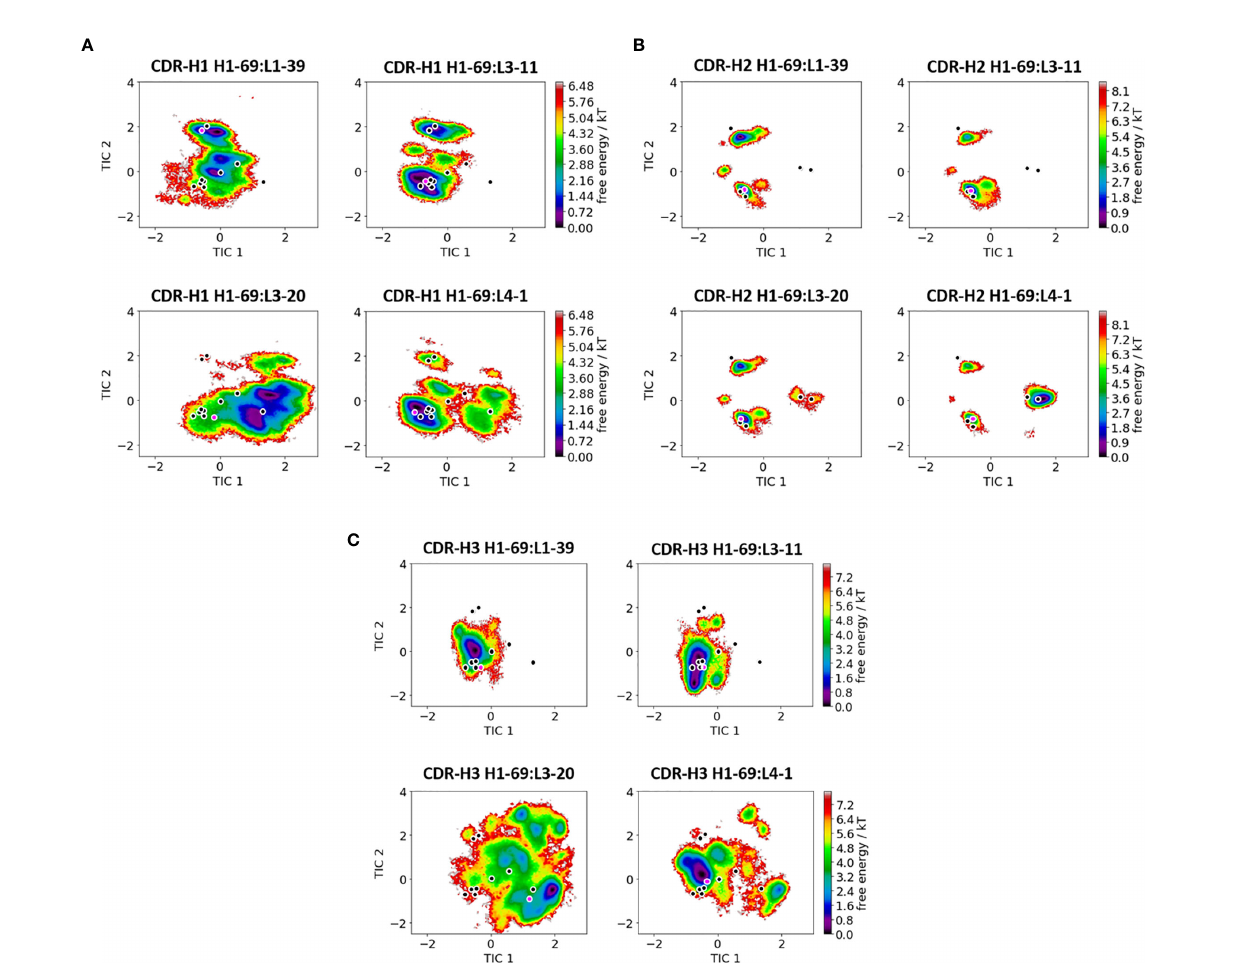
FIGURE 1 | Comparison of all V H -CDR loops consisting of the heavy chain germline H1-69. (A) Shows the free energy surfaces of the CDR-H1 loop paired with different light chain germlines in the same coordinate system. The available canonical cluster structure representatives from the PyIg database for the CDR-H1 loop of length 13 are projected into the free energy surface and are depicted in black. In pink the respective crystal structures, which were used as starting structures are illustrated (PDB accession codes: 5I15, 5I16, 5I17 and 5I18). (B) Displays the resulting free energy landscapes for the CDR-H2 loop projected into the same coordinate system. The canonical cluster structures of the CDR-H2 loop of length 10 are projected and illustrated in black. The pink dot represents the starting X-ray structures for the simulations. (C) Shows the free energy landscapes of the CDR-H3 loop. As for the CDR-H3 loop no canonical cluster structures are available, we projected the 16 CDR-H3 loop crystal structures, which were investigated in this study into the free energy landscape. The pink dot shows the CDR-H3 loop starting structure for the